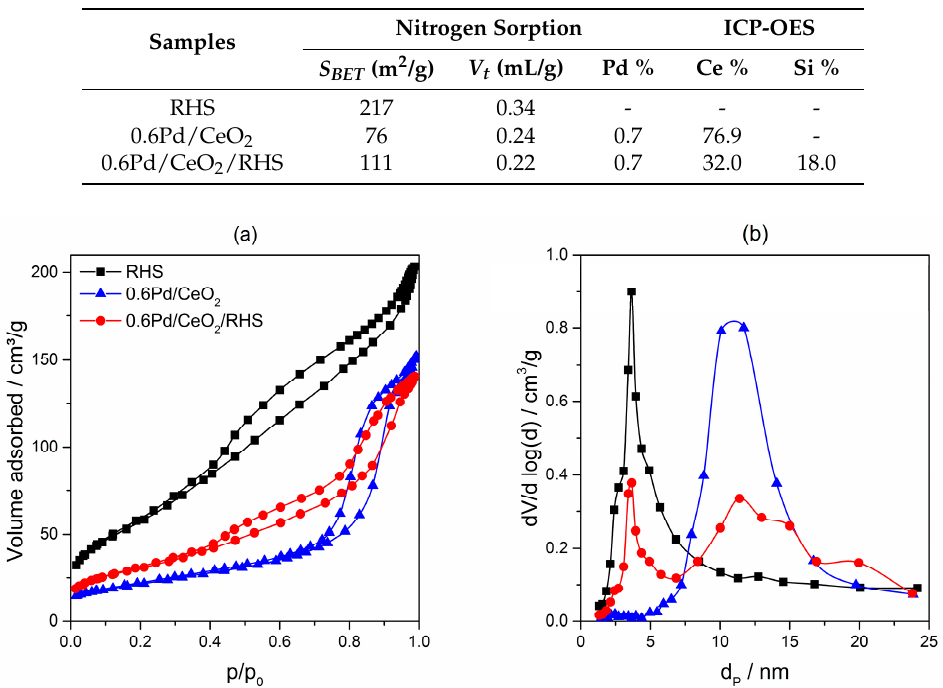
Table 1. BET-specific surface area ( S BET ) calculated according to Ref. [28], average pore volume ( V t ) as well as element analysis data.